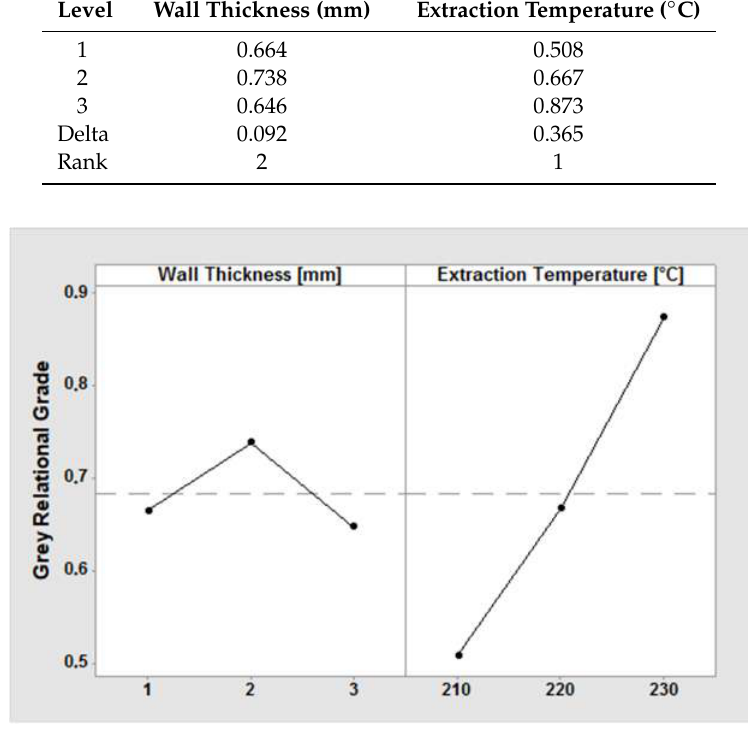
Figure 6. Plot of means for grey relational grade.